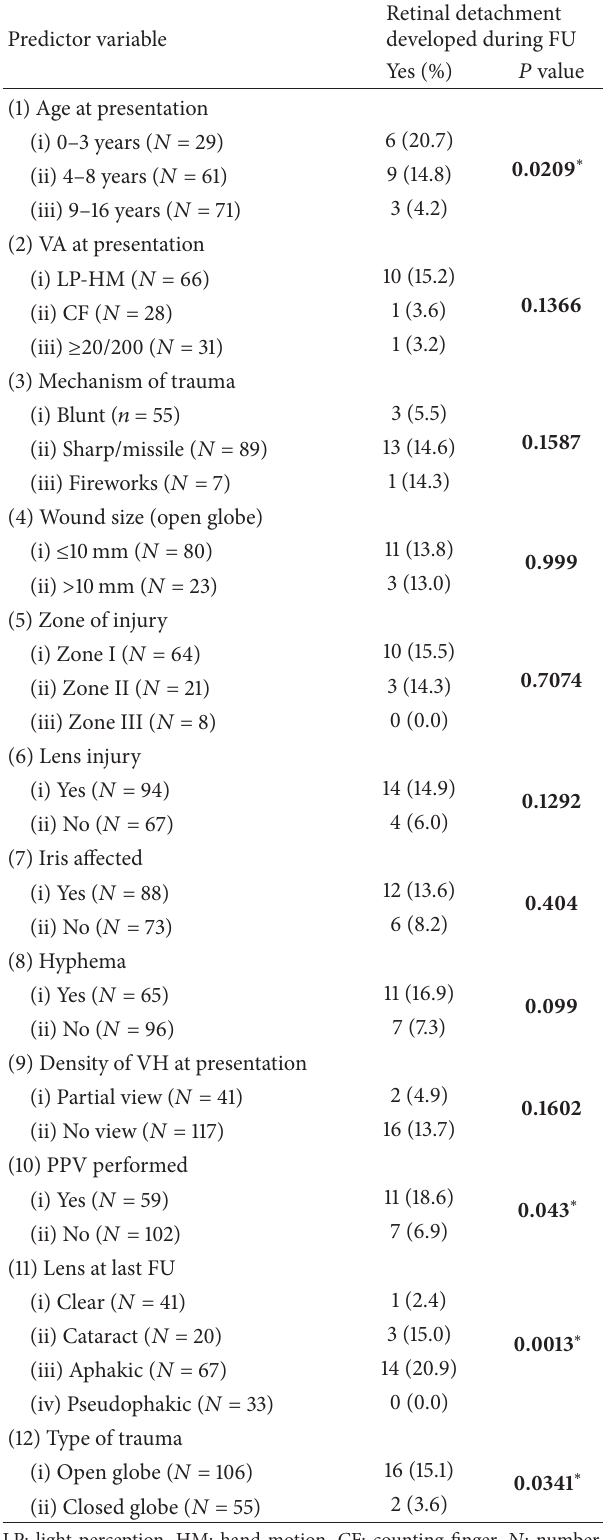
Table 10: Factors predicting retinal detachment for eyes with vitreous hemorrhage caused by accidental trauma during